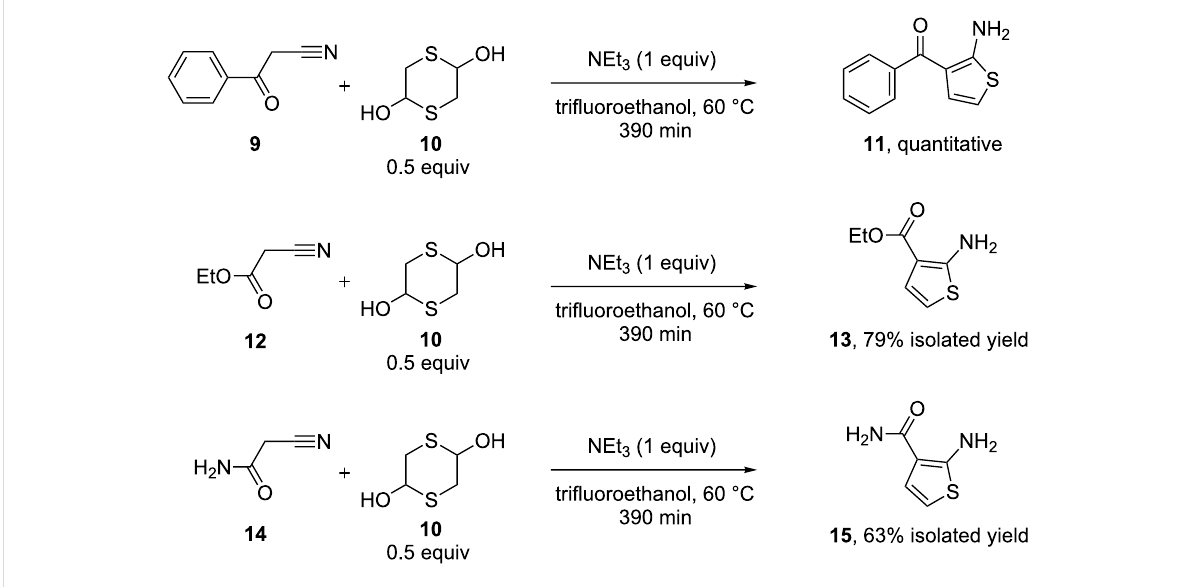
Scheme 1: Illustration of substrates that form thiophenes under Gewald-type conditions.